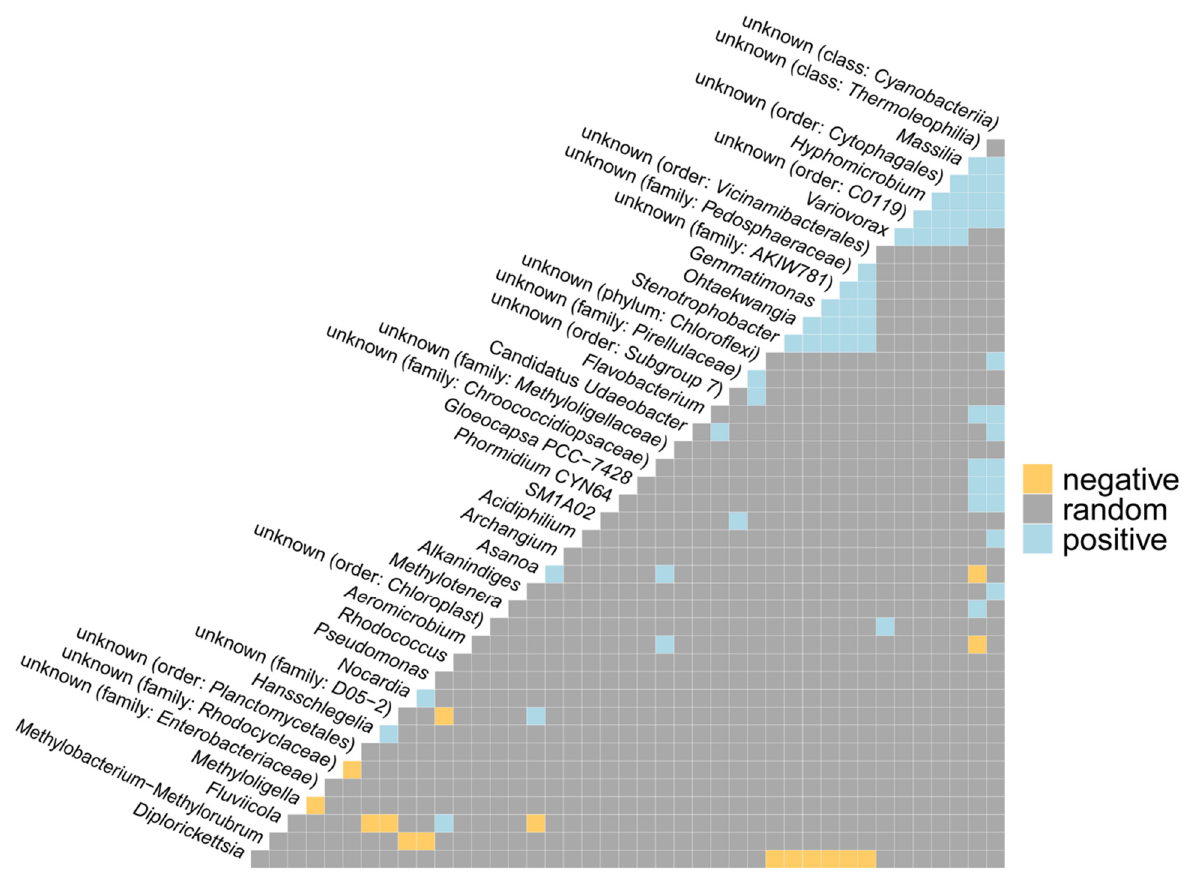
Figure 5. Co-occurrence analysis between detected taxa with positive, negative, and random interactions shown. Only those taxa that were present in any sample with at least 0.5% of occurrence were analyzed.